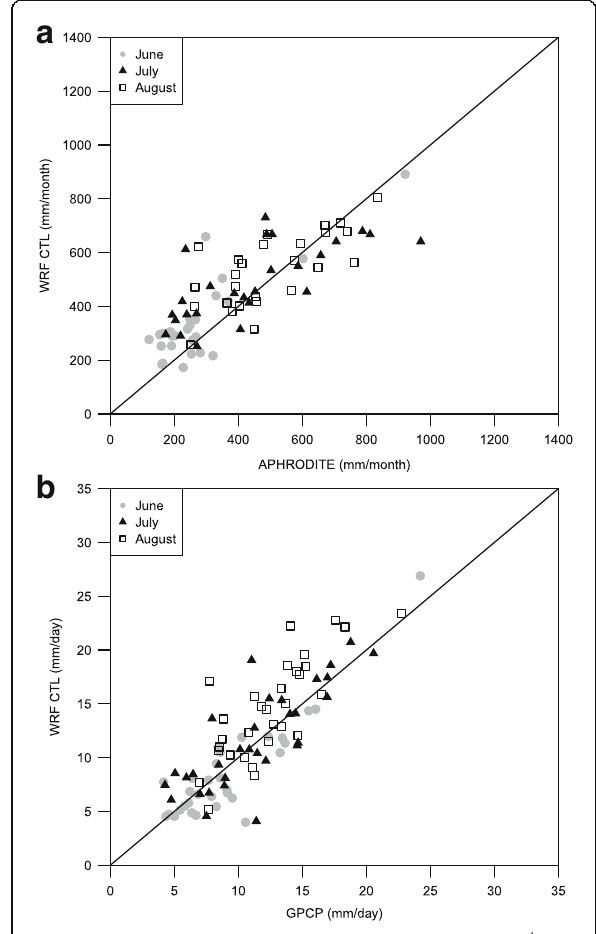
Fig. 4 a Scatter plot of the monthly total rainfall (mm month − 1 ) from the CTL simulations compared with APHRODITE data for 1982 – 2007. b Scatter plot of monthly mean of daily rainfall (mm day − 1 ) from the CTL simulations compared with GPCP data for 1982 –